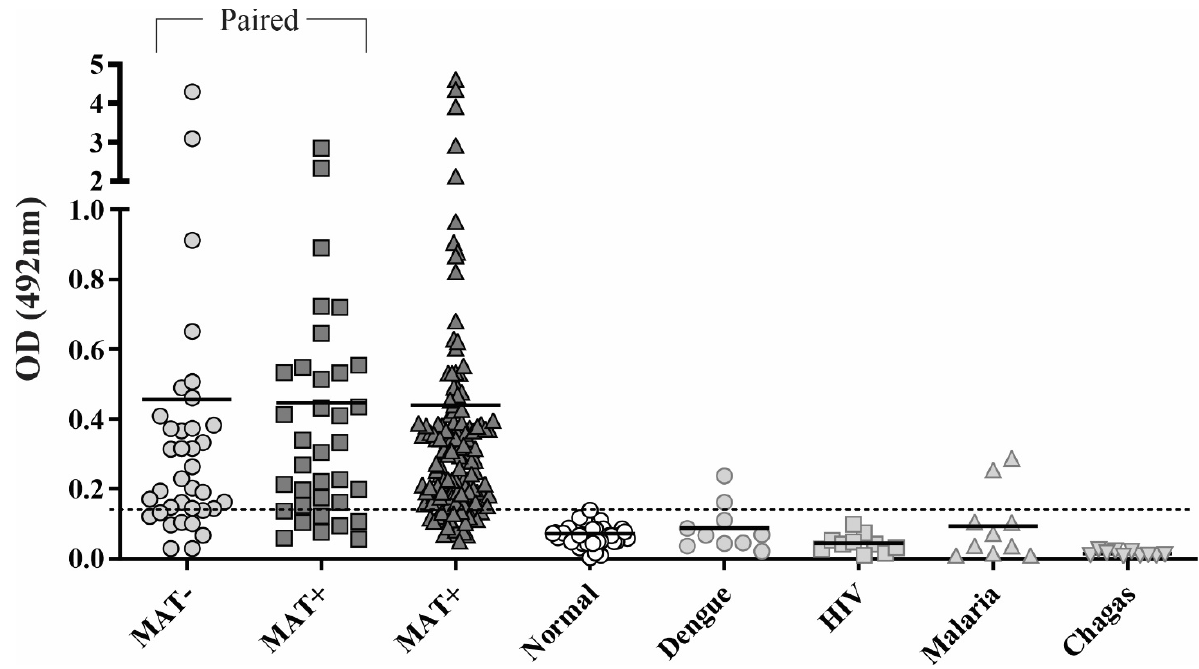
Figure 3. Reactivity of rChi2 with confirmed leptospirosis cases and unrelated febrile illness. The reactivity of the chimeric protein experimentally with human leptospirosis paired serum samples (n = 36) at the onset of disease (MAT-negative) and in the convalescent phase of disease (MAT- positive) and additional MAT+ samples (n = 142) were determined via ELISA. The cutoff value is shown as a dashed line, and it was defined as the mean plus 3 standard deviations obtained with NHS (n = 50). Sera from patients with unrelated febrile illness, including dengue, Chagas’ disease, HIV, and malaria (n = 10 each), were also employed for assessing the specificity of the reactions.